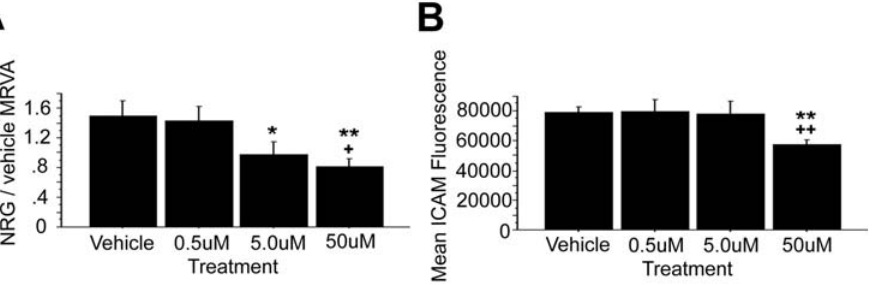
Figure 5. Akt inhibition causes a dampening of the NRG/vehicle MRVA measure. Administration of the Akt Inhibitor X in water vehicle (n=5) caused a dose-dependent decline in the NRG/vehicle MRVA (A) . Unlike PI3K inhibition, Akt inhibition was associated with a statistically significant reduction in mean ICAM (B) and mean NRG (not shown) raw fluorescence values at the high dose only with no trend at lower doses. Compared with the vehicle control, * represents p , 0.05 and ** represents p , 0.01. Compared with the low dose, + represents p , 0.05 and ++ represents p ,